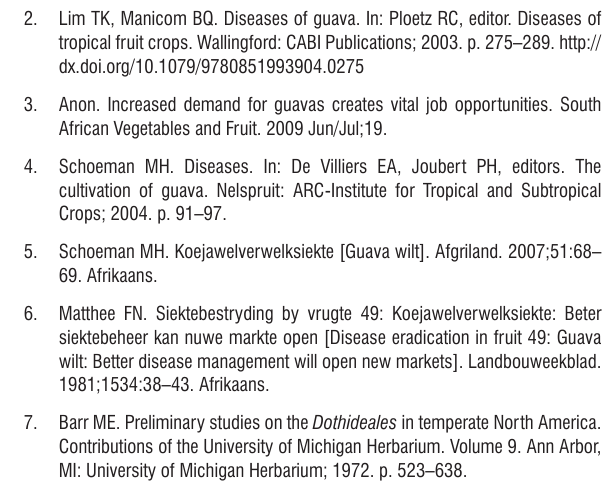
Internal transcribed spacer sequence